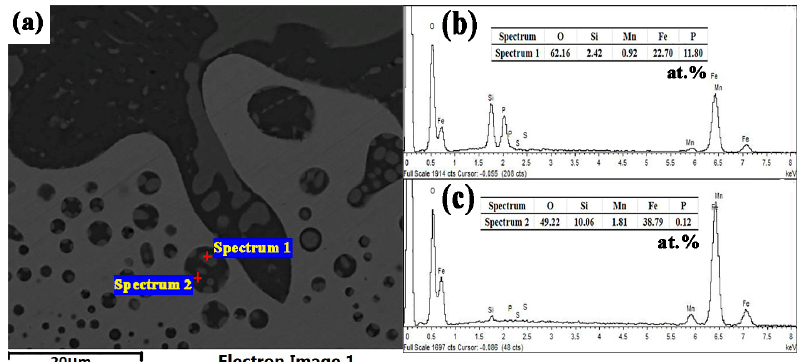
Figure 5. The chemical composition of the dispersive particles obtained by the point analysis method of EDS ( a ) the morphology of dispersive particles; ( b ) the elemental constitution of spectrum 1; ( c ) the elemental constitution of spectrum 2.